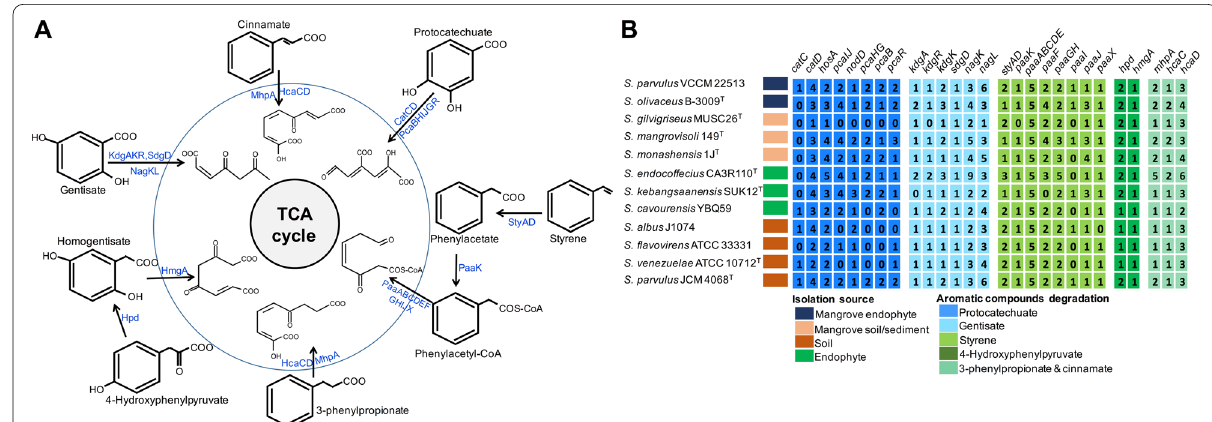
Fig. 5 Complete pathways of aromatic compound degradation identified in S. parvulus VCCM 22513. A Six peripheral catabolic pathways for the aromatic compound degradation and their corresponding metabolites predicted in the S. parvulus VCCM 22513 genome. Ring‑cleavage product structures of central aromatic catabolic pathways are shown inside the circle, which are fueled into tricarboxylic acid (TCA) cycle. B Distribution of genes involved aromatic compound degradation in S. parvulus VCCM 22513 and 11 Streptomyces